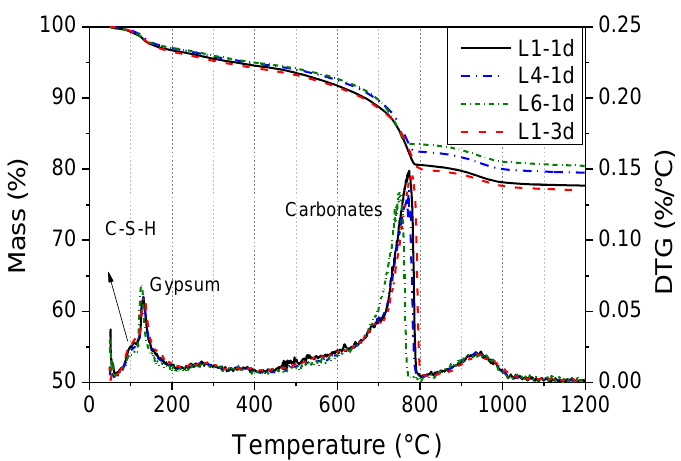
Figure 14. TG – DTG analyses of samples with different w/s values and curing times (L1, 1:5; L4, 1:8; L6, 1:10).